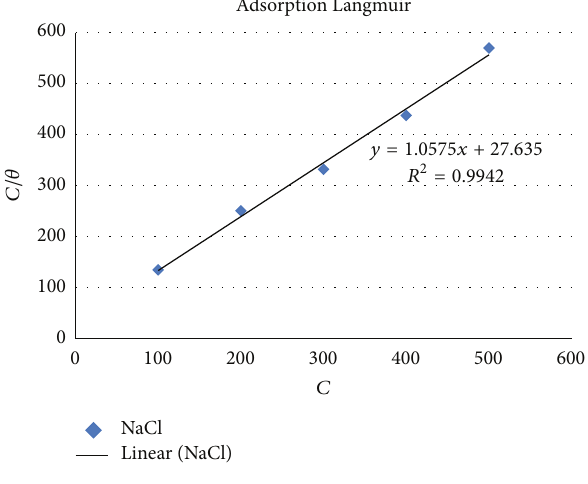
Figure 5: Isotherm